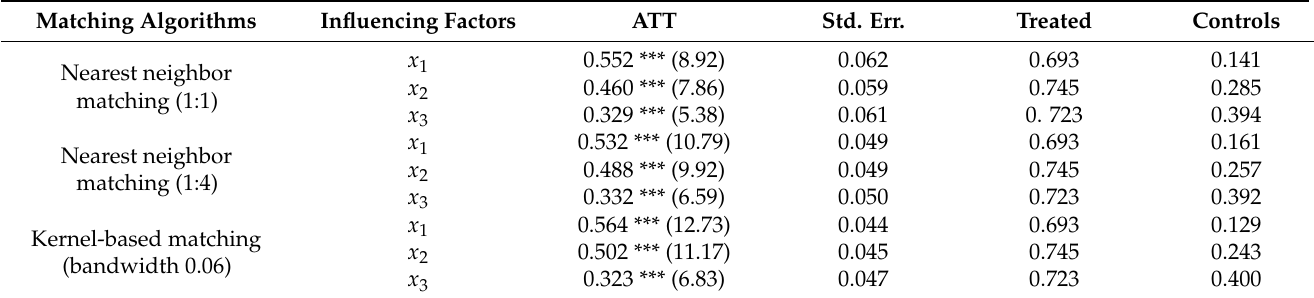
Table 3. Average processing effect of different matching algorithms based on